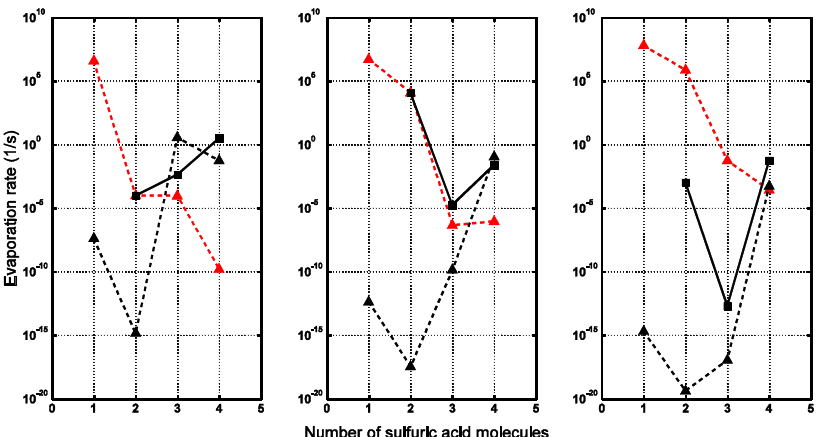
Fig. 3. Evaporation and fission (non-monomer evaporation) rates from DMA / H 2 SO 4 clusters. Left panel: clusters with two DMA molecules. Middle panel: clusters with three DMA molecules. Right panel: clusters with four DMA molecules. Red dashed lines are the evaporation of DMA from the cluster, black dashed lines are the evaporation of sulfuric acid from the cluster, and solid black lines are the cluster fission reactions leading to the formation of the most stable daughter cluster ((H 2 SO 4 ) 2 •(CH 3 ) 2 NH for fission of two DMA clusters and (H 2 SO 4 ) 2 •((CH 3 ) 2 NH) 2 for fission of three and four DMA clusters).